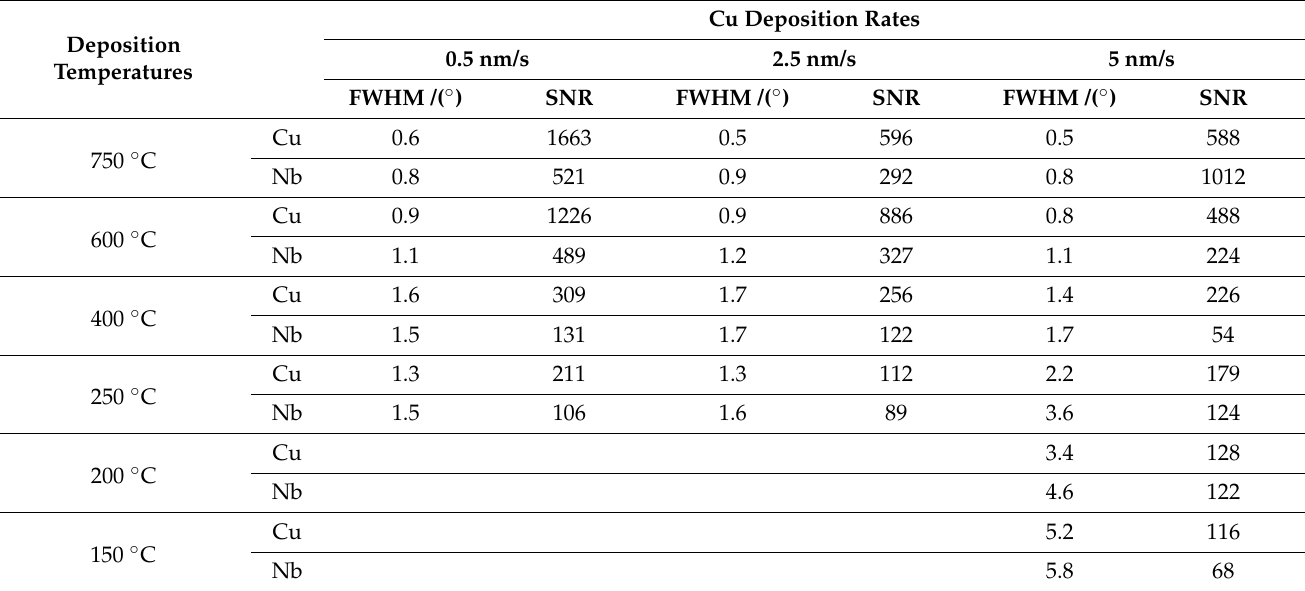
Table 2. The average FWHM and SNR of the main peaks obtained from XRD curves of Cu/Nb multilayer films deposited at different temperatures and Cu deposition rates [2]. Reprinted with permission from [2] Elsevier